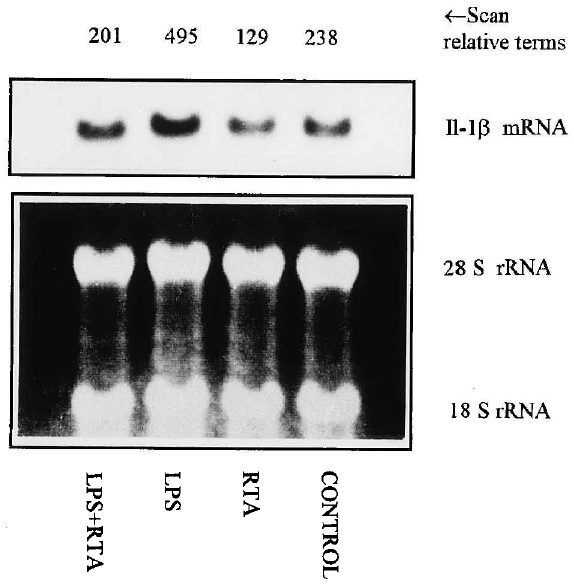
FIG. 2. The effect of RTA (10 m M) and/or LPS (500ng/ml) on IL- 1 b mRNA abundance in PMA-primed U937 cells after 18h incubation with LPS and/or with RTA (cf. Fig. 1). For comparison, the UV picture of 18 S and 28 S rRNA in the ethidium bromide-stained gel is shown. Densitometric scans of IL-1 mRNA are expressed in arbitrary units.